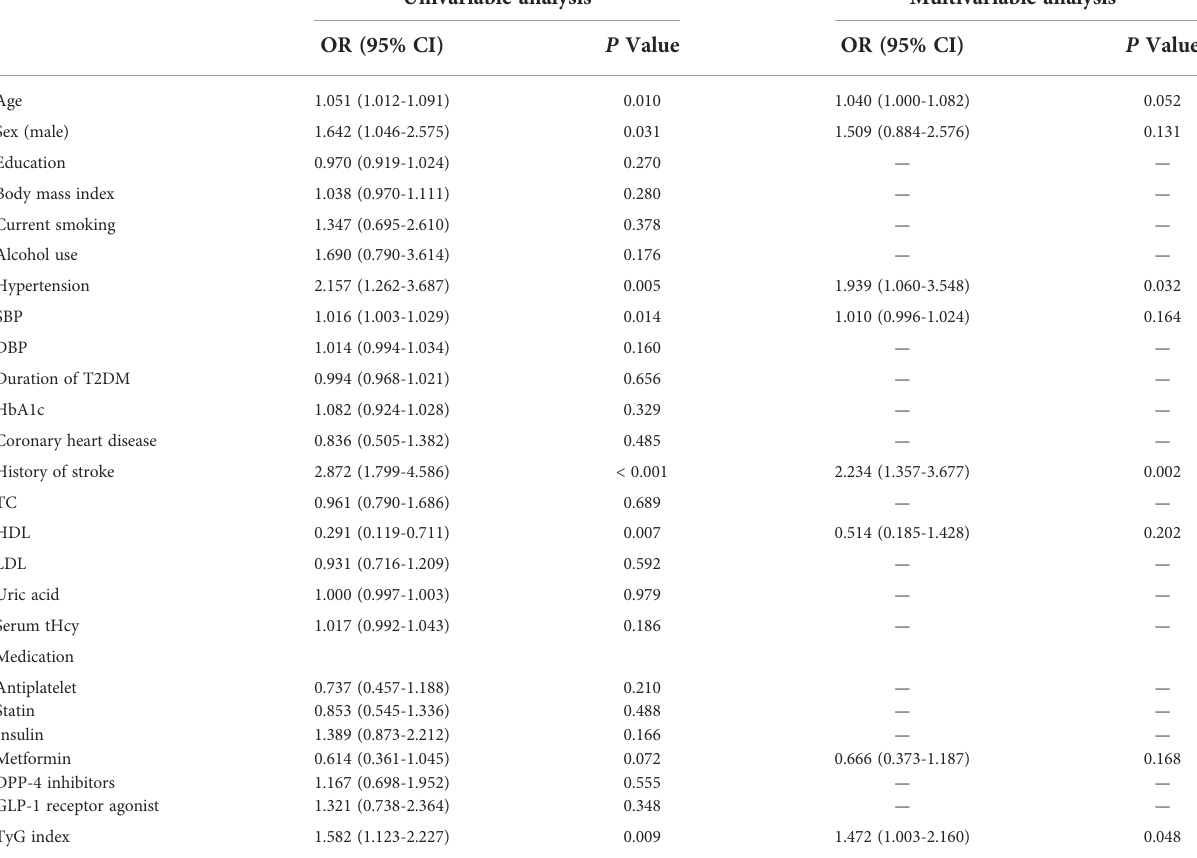
TABLE 3 The logistic regression analyses between possible predictors and severe CSVD burden.